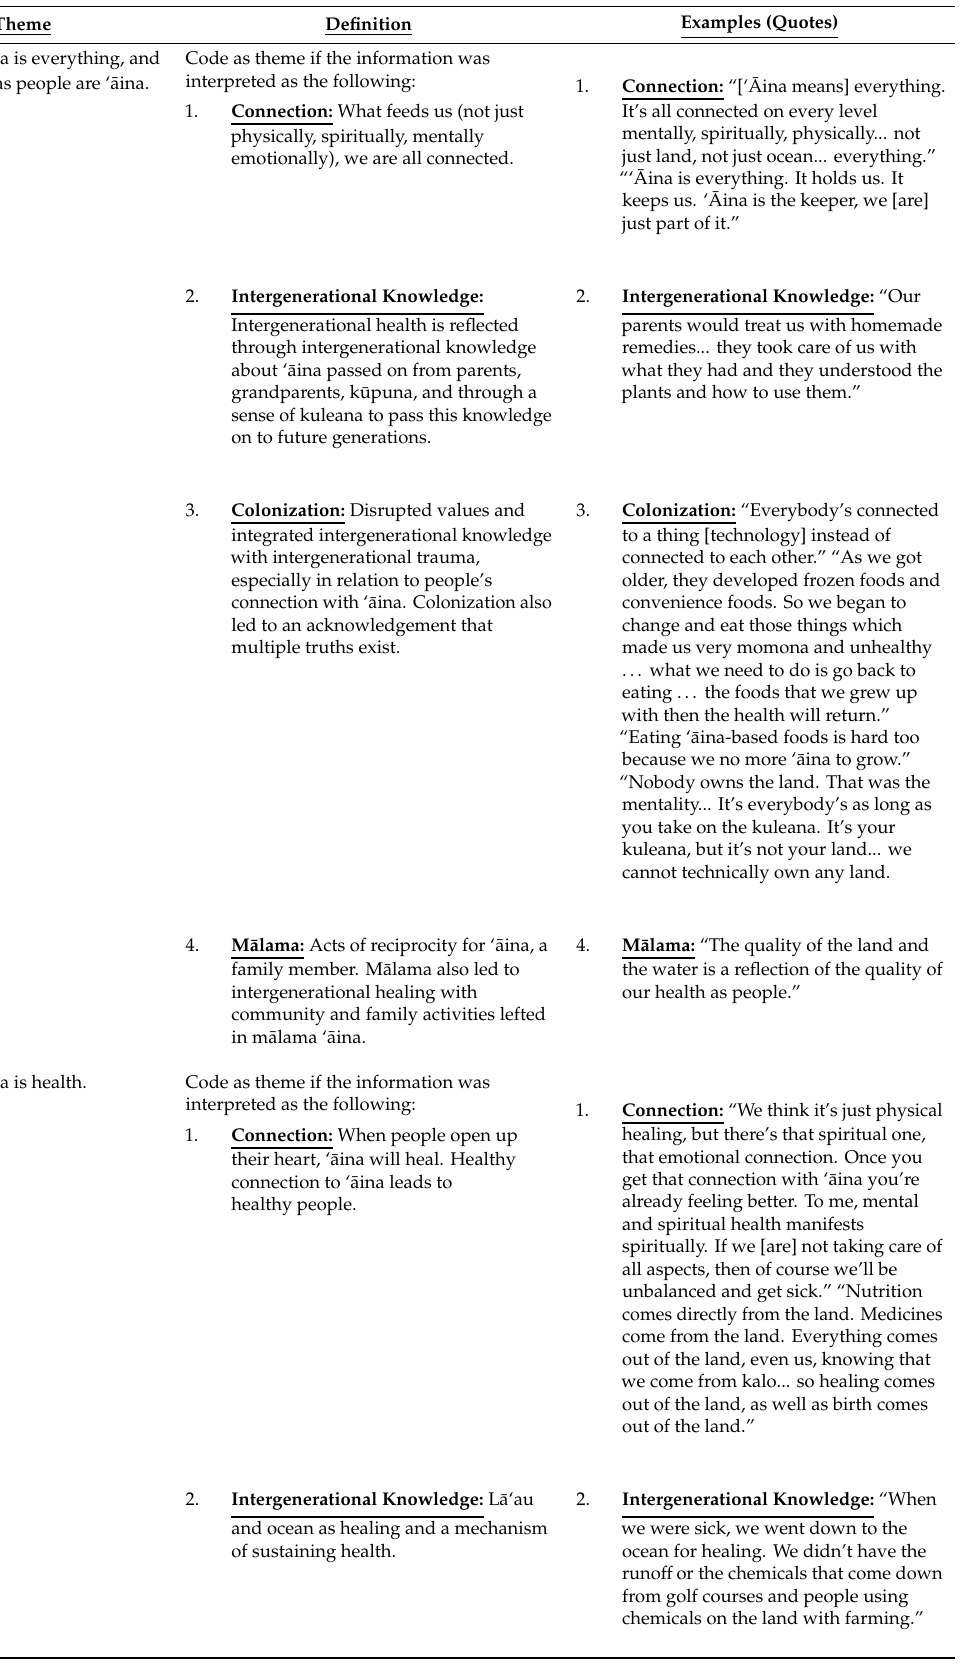
Table 2. Summary of